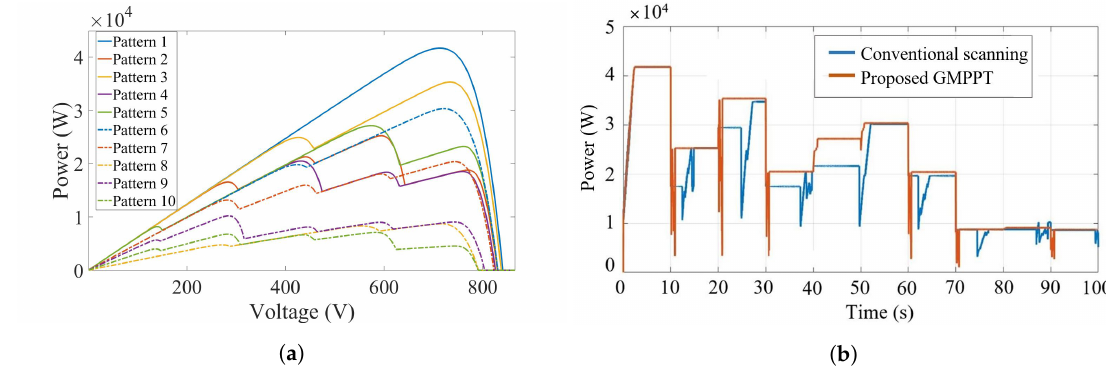
Figure 11. Short-term testing. ( a ) P-V characteristic curves for short-term testing; ( b ) result of tracked power. Table 4. Performance comparison of conventional scanning and proposed GMPPT algorithm using short-term